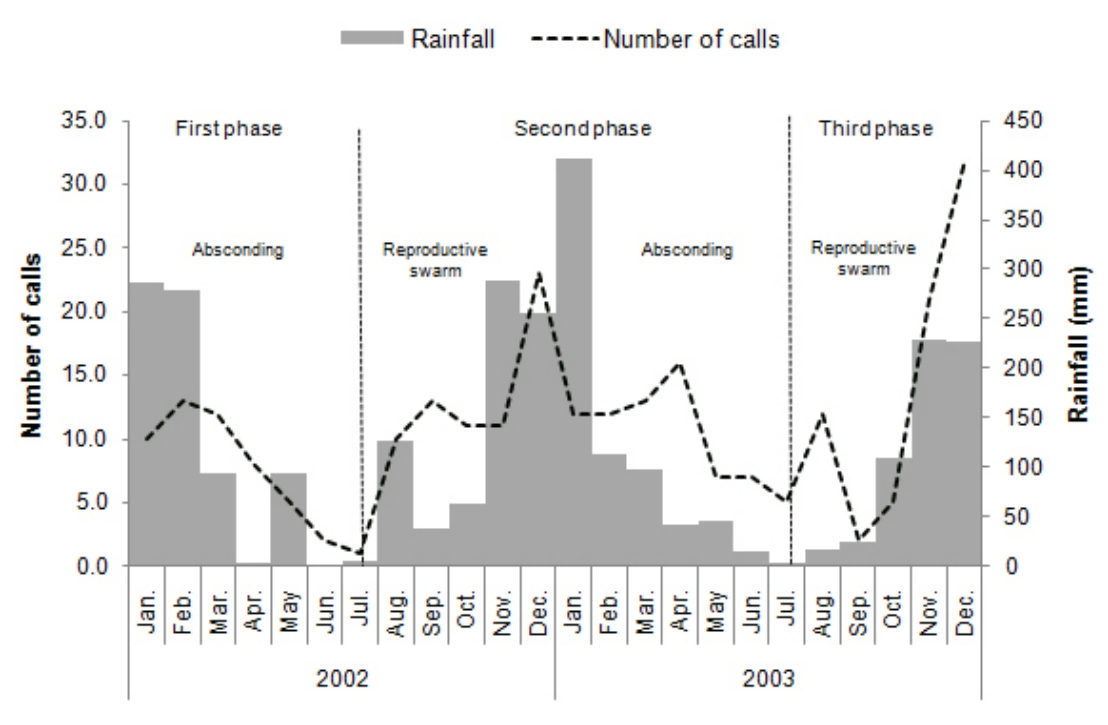
Figure 1. Number of calls to the Rio Claro fire brigade and average rainfall during 2002 and 2003.